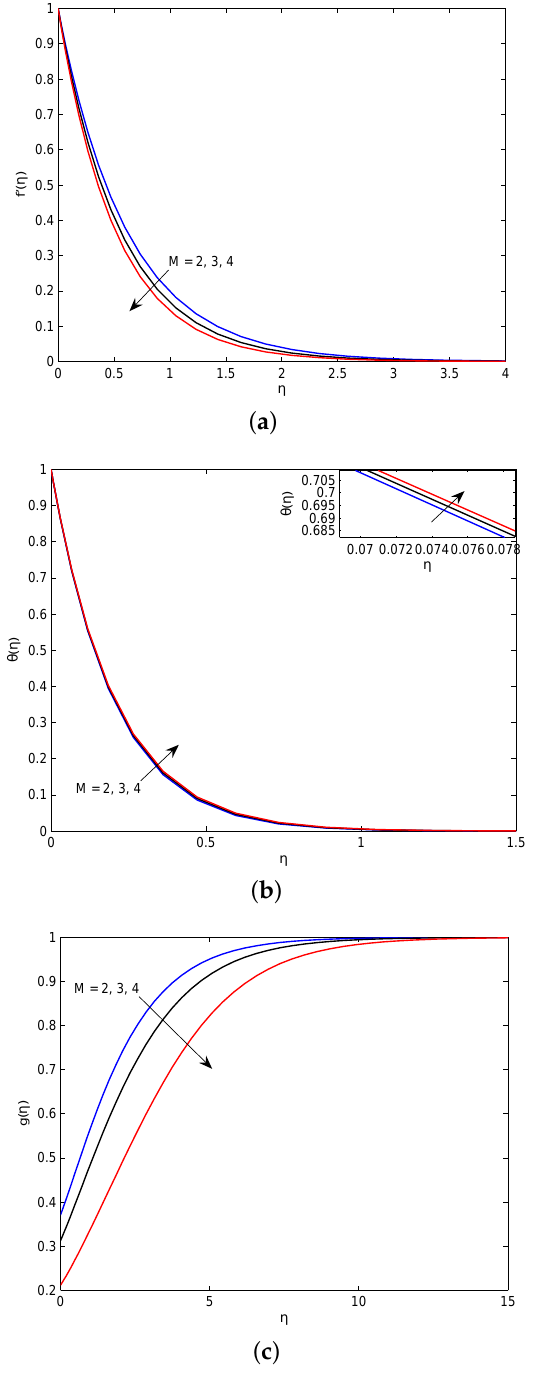
Figure 4. Variations in ( a ) f (cid:48) , ( b ) θ , and ( c ) g with respect to M when φ = 0.2, K = 0.5, K s = 0.5, β h = 2, Sc = 1, and Pr =